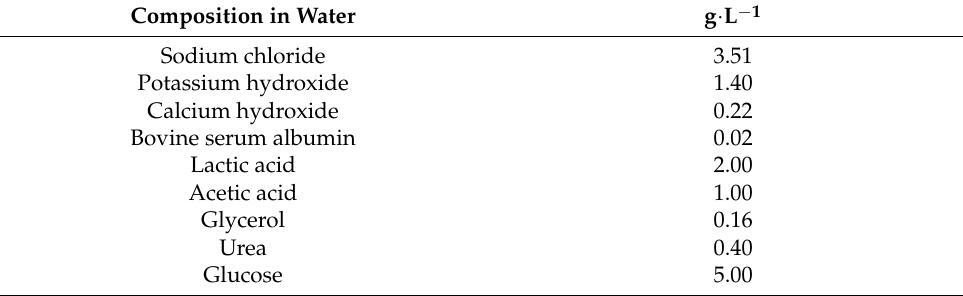
Table 2. Composition of